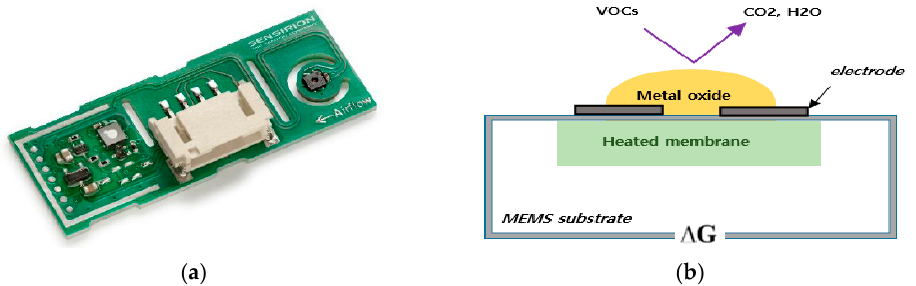
Figure 3. ICT ‐ TVOC sensor (SVM30) ( a ) semiconductor sensor structure ( b ) principle of semiconductor